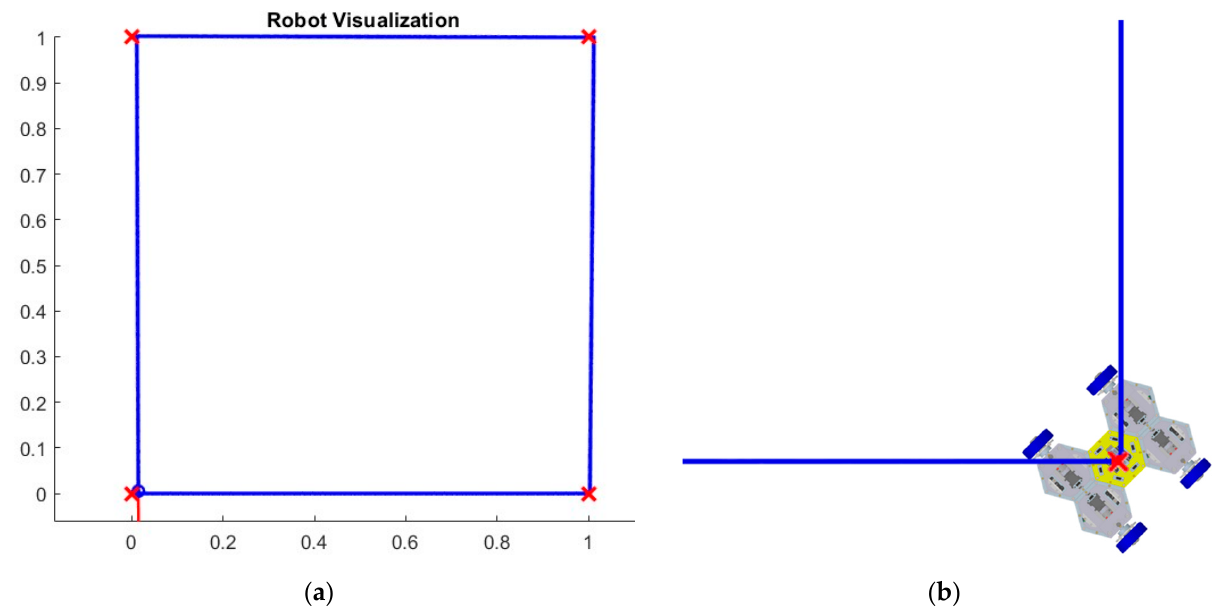
Figure 27. The path traveled by the robot. ( a ) Trajectory resulting from the simulation. ( b ) The 90° turn of the robot in the simulation. turn of the robot in the